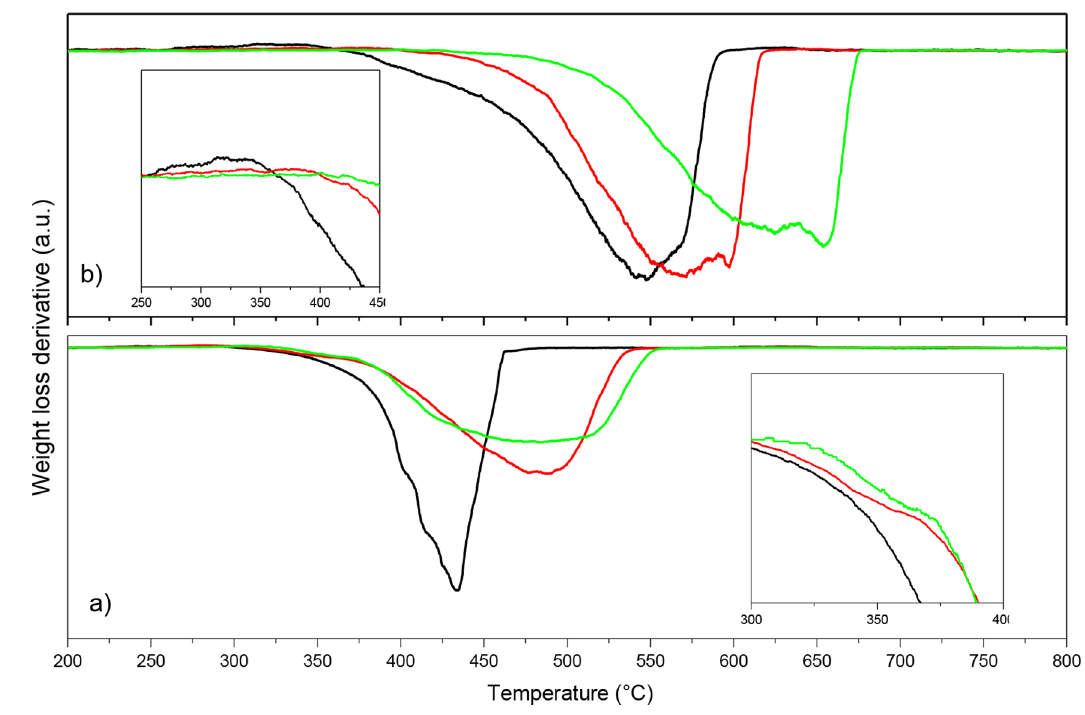
Figure 1. TG weight loss derivative of (a) free Ni samples: − C500, − C600, − C700; and (b) Ni-C samples: − Ni-C500, − Ni-C600, − Ni-C700.